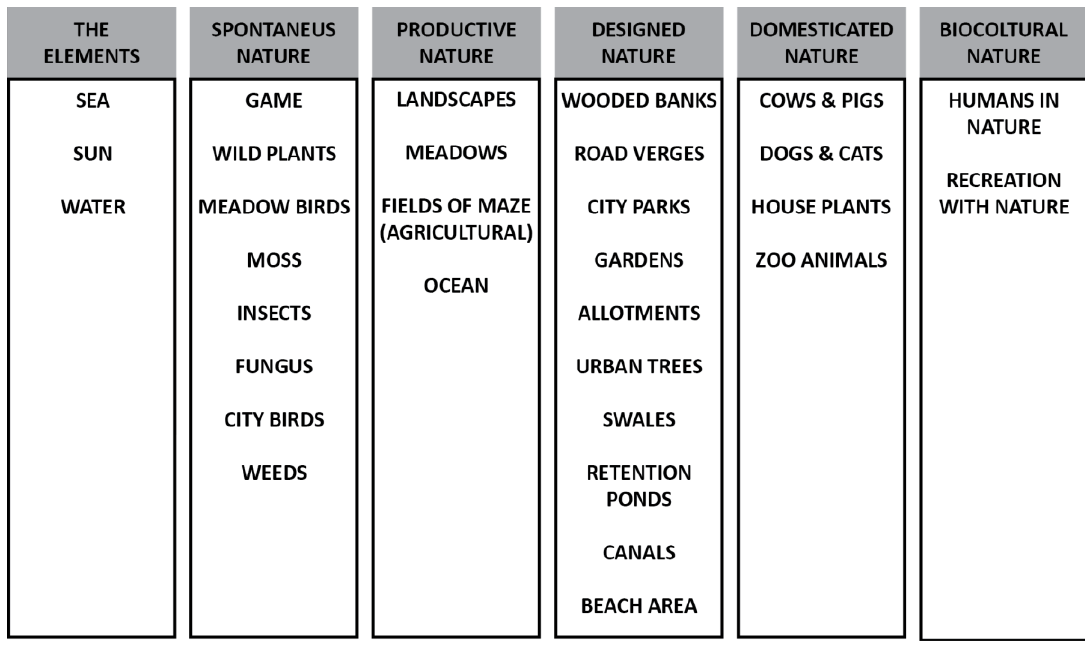
Figure 2. The used image categorization classifies urban nature into six categories based on Dimensions of Nature. Examples of image content are shown below for each urban nature category. Adapted from Buijs (2009).